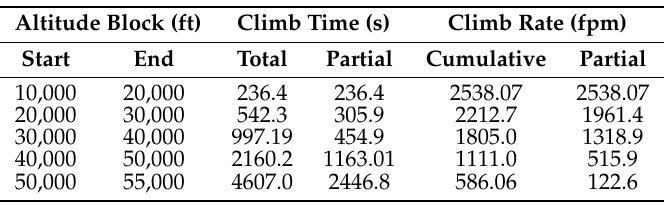
Figure 4. ( a ) NS872 climb up to cruise climb altitude and ( b ) cruise climb for Mission 872-0060. FL, Flight Level. Table 2. Global Hawk total and partial climb rates for Mission